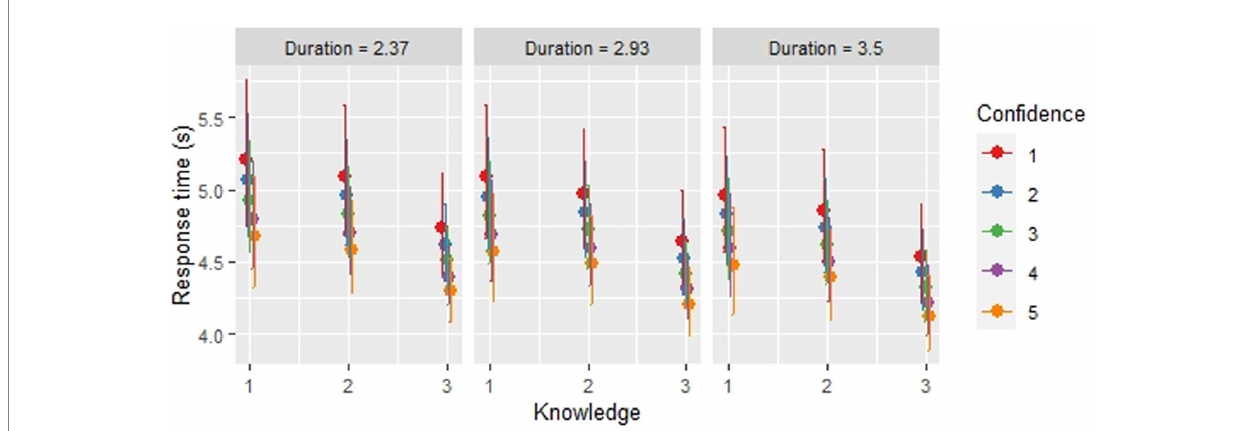
FIGURE 4 The relationship between sentence comprehension speed, knowledge, confidence and stimulus duration based on GLMM Model 8. In each plot, the point in the middle represents the predicted value of the response time for sentence comprehension at each knowledge level derived from Model 8. The lines indicate the 95% confidence intervals for the predicted values. The numbers at the bottom indicate the level of knowledge: 3. Producible, 2. Only comprehensible, and 1. Not comprehensible. The points with different colors show each confidence level from 1 to 5. The graph in the middle shows the result with the mean of stimulus duration. The left and rights graphs are based on the mean of stimulus duration with − 1 and + 1 standard deviations. Frequency is not included in the graphs, as it did not significantly affect sentence comprehension